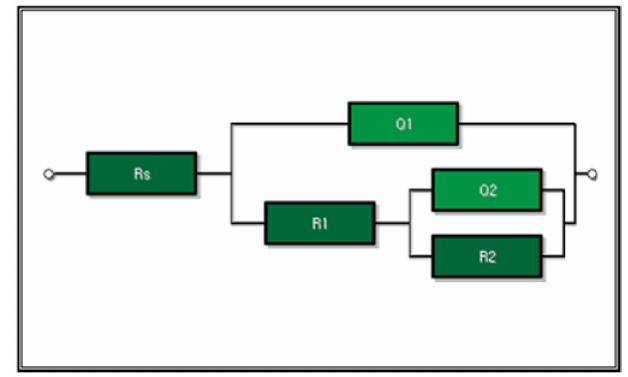
Figure 8. Equivalent circuit model representing the corrosion behavior of the post-laser-treated TZM alloy immersed in 3.5% NaCl solution for seven